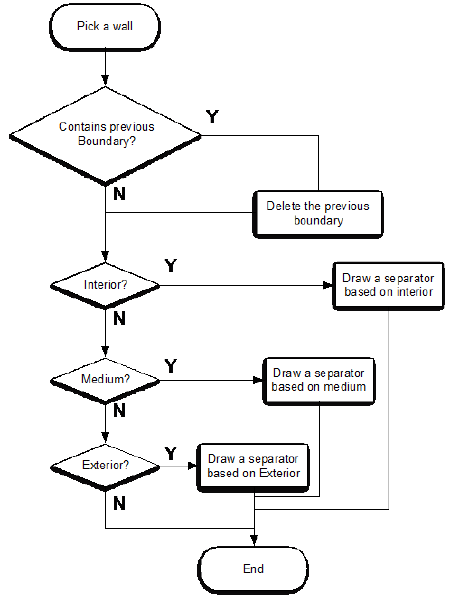
Figure 4. Workflow of creating